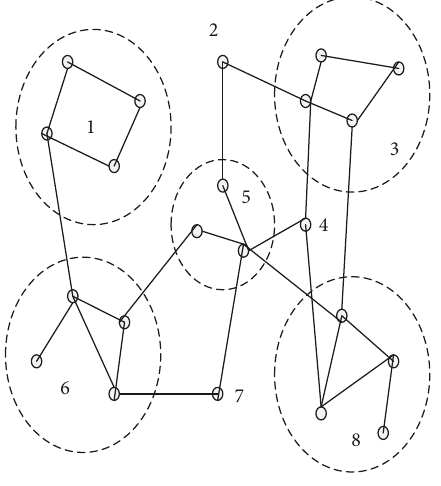
Figure 2: Topology of the power